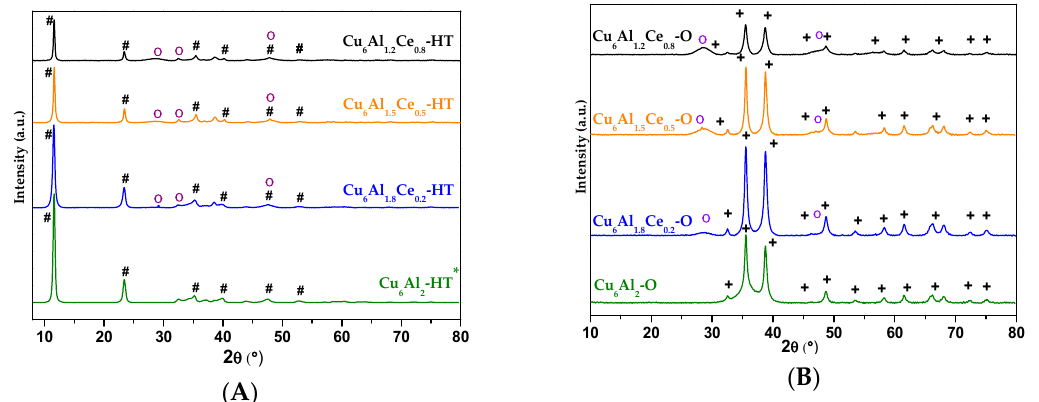
Figure 1. Diffraction patterns of the hydrotalcite precursors ( A ) and the mixed oxide samples ( B ). #: Cu 6 Al 2 (OH) 16 CO 3 ,4H 2 O; +: CuO; O: CeO 2 ; * mitigated intensity.